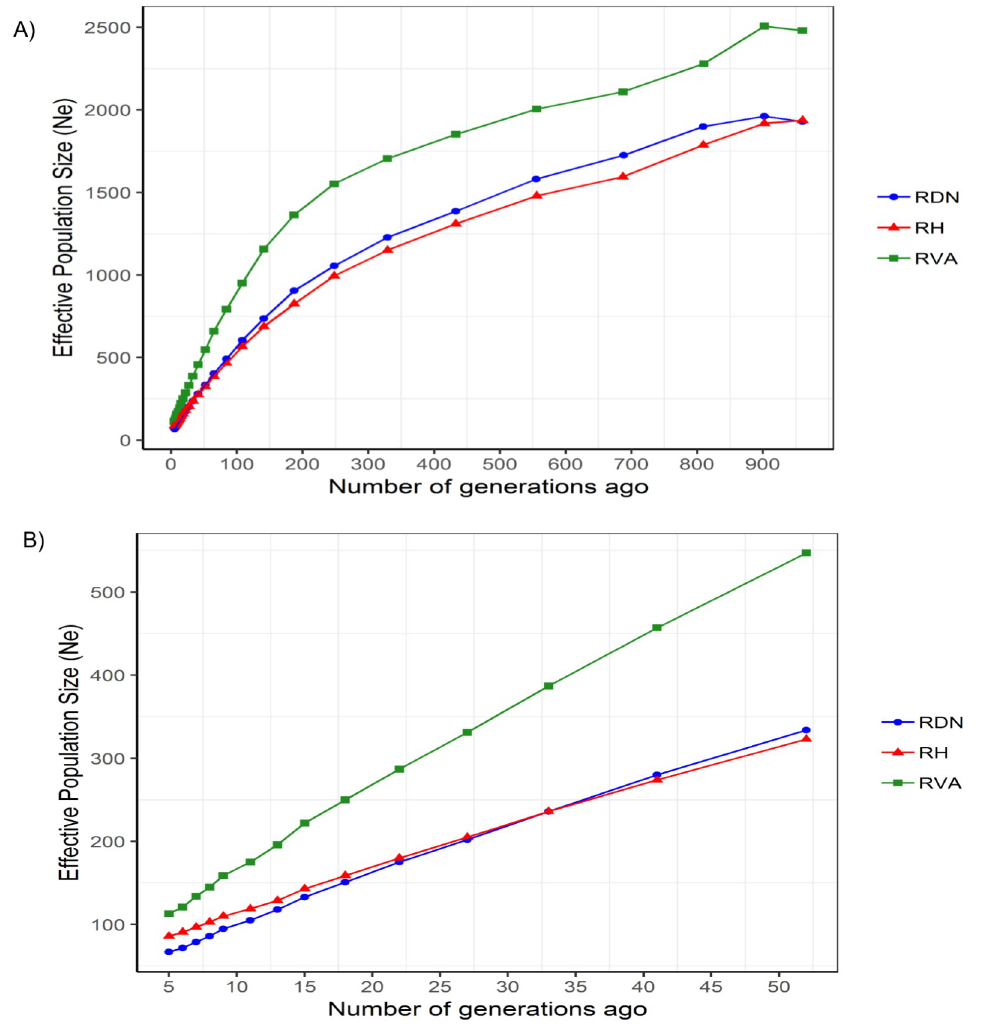
Fig 2. Trends in LD based effective population size for Angler (RVA), Red-and-White dual-purpose (RDN) and Red Holstein (RH). A) Across 1000 generation and B) across 52 generations ago.